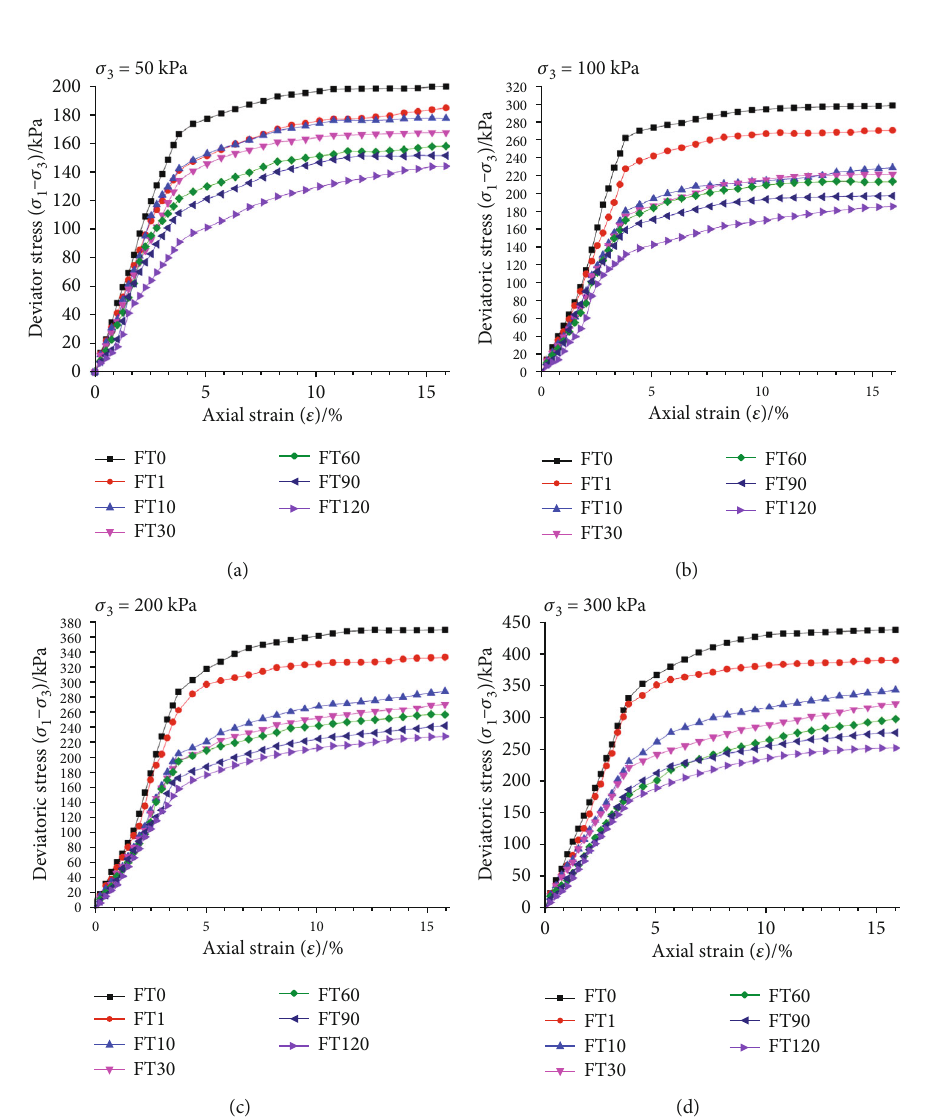
Figure 2: Stress-strain relationship obtained from CU triaxial tests at di ff erent